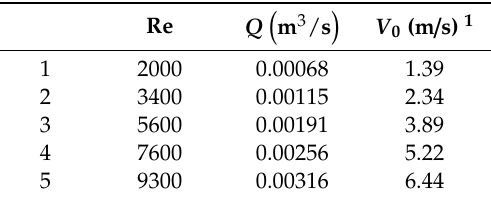
Table 1. Experimental conditions.